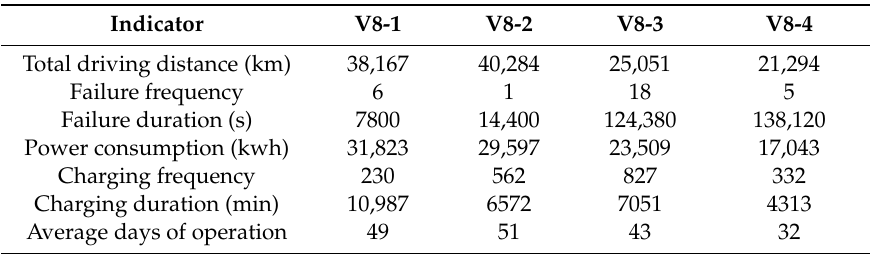
Table 6. Indicator Data Collected for Group A.